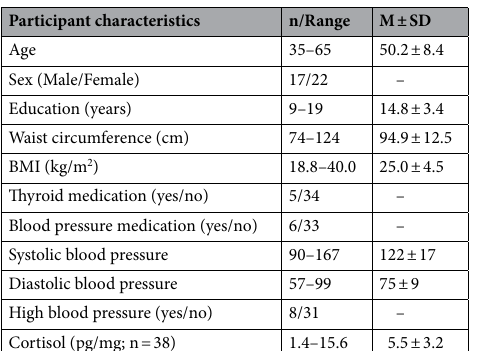
Table 1. Participant characteristics. Education was measured in years until the highest achieved degree. High blood pressure was defined as systolic pressure ≥ 140, and/or diastolic pressure ≥ 90.